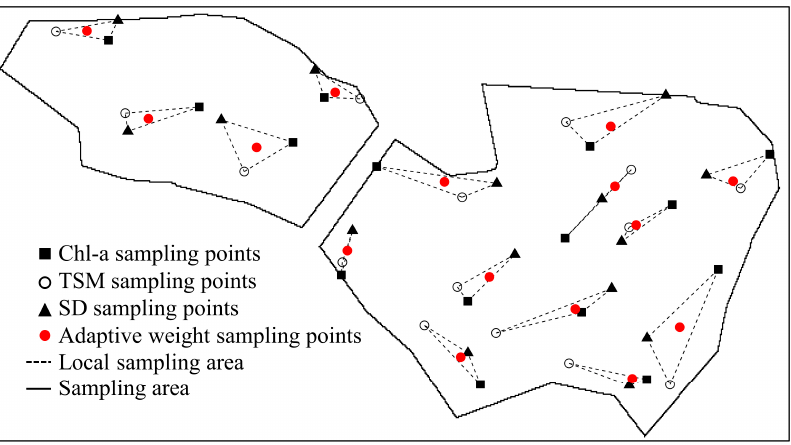
Figure 8. Example of Adaptive weight sampling points. Table 4. Spatial representative evaluation of various sampling